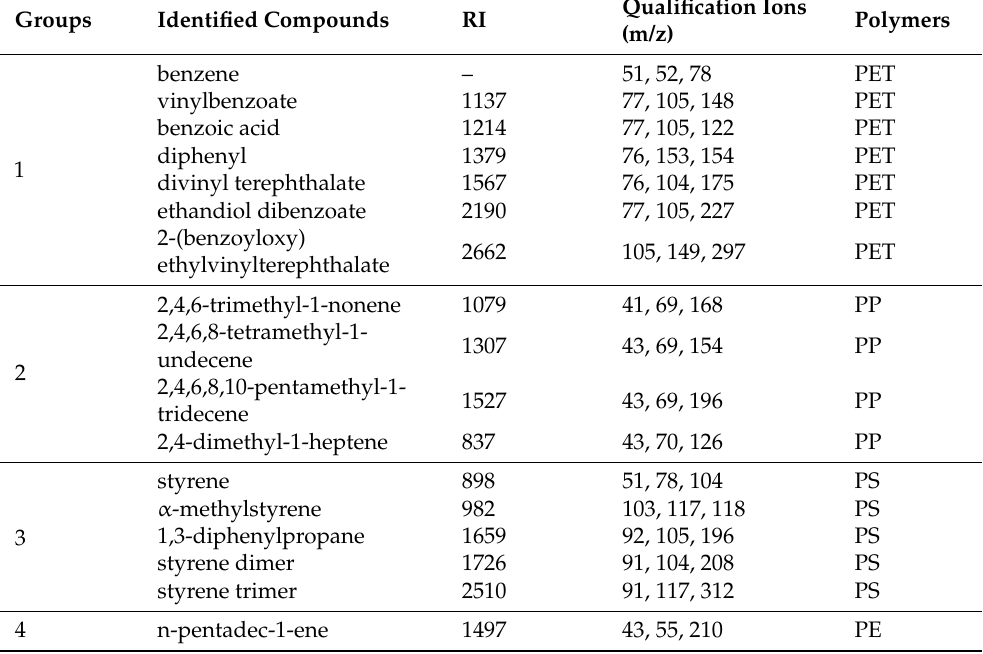
Qualification Ions (m/z)